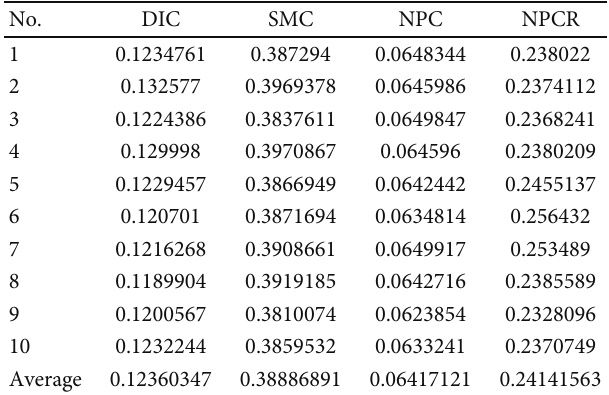
Figure 6: Height error changes with time under di ff erent Table 2: Standard deviation comparison of di ff erent controllers.